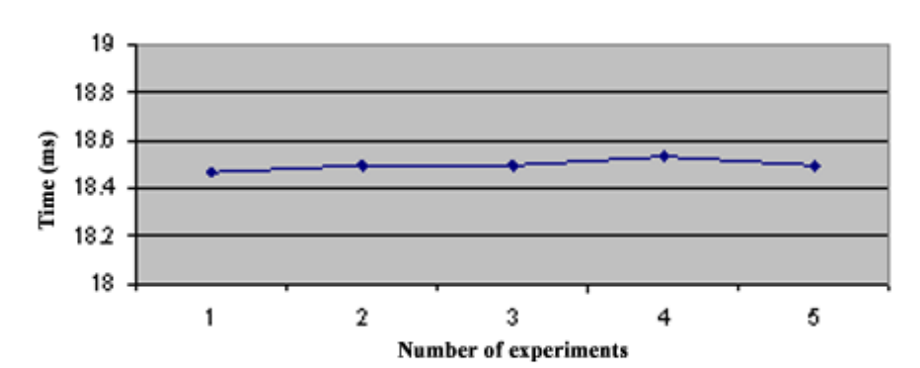
Figure 6. Convergence Time of Topology 3.